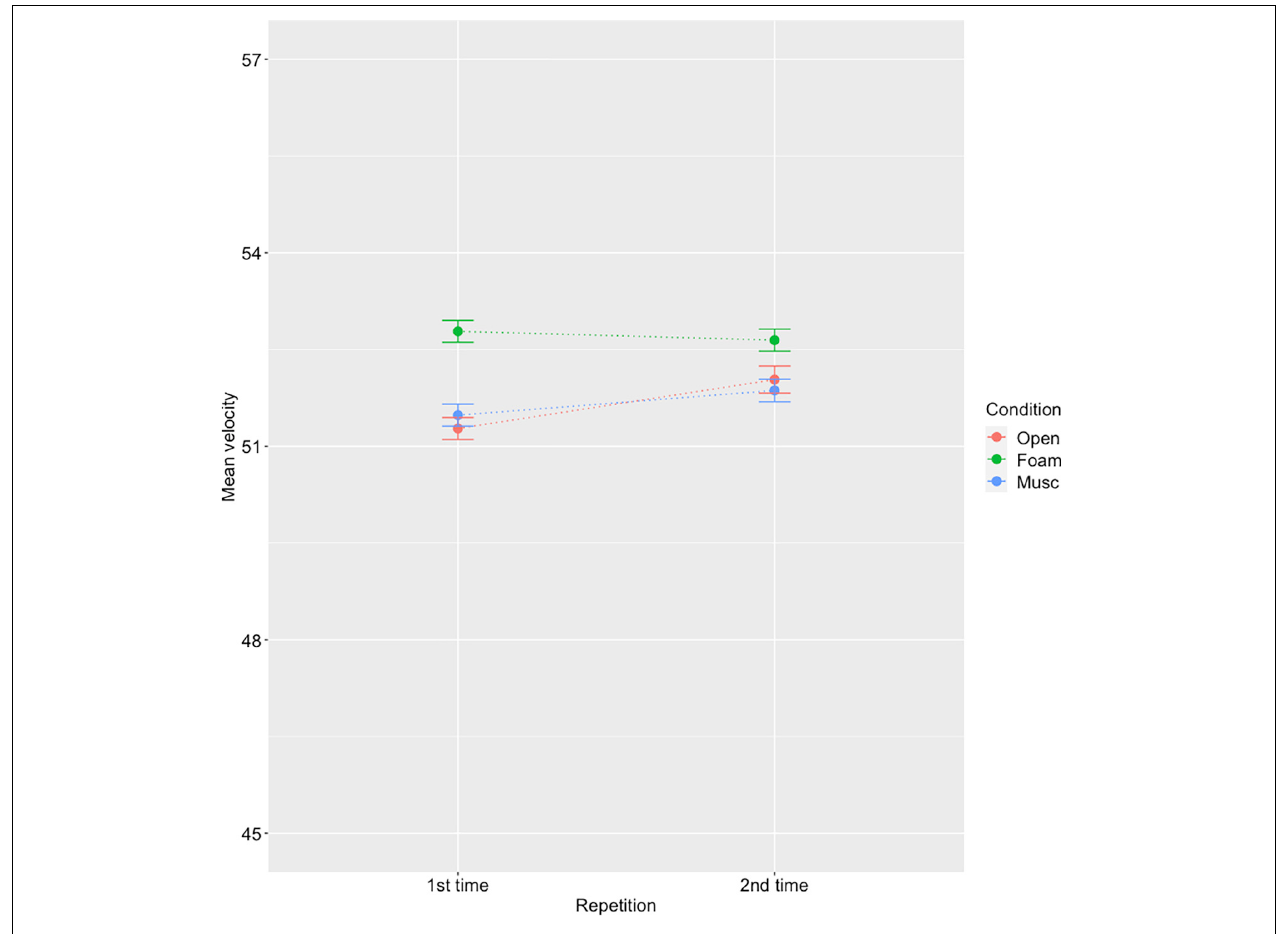
FIGURE 5 | Mean velocity and standard error by repetition and hearing condition for the familiar excerpt E 0 (for 11 participants). While there was a significant effect of condition on the 1 st - time performance, no significant differences were observed between the open and hearing protection conditions on the 2 nd - time performance, indicating an acclimatization effect.